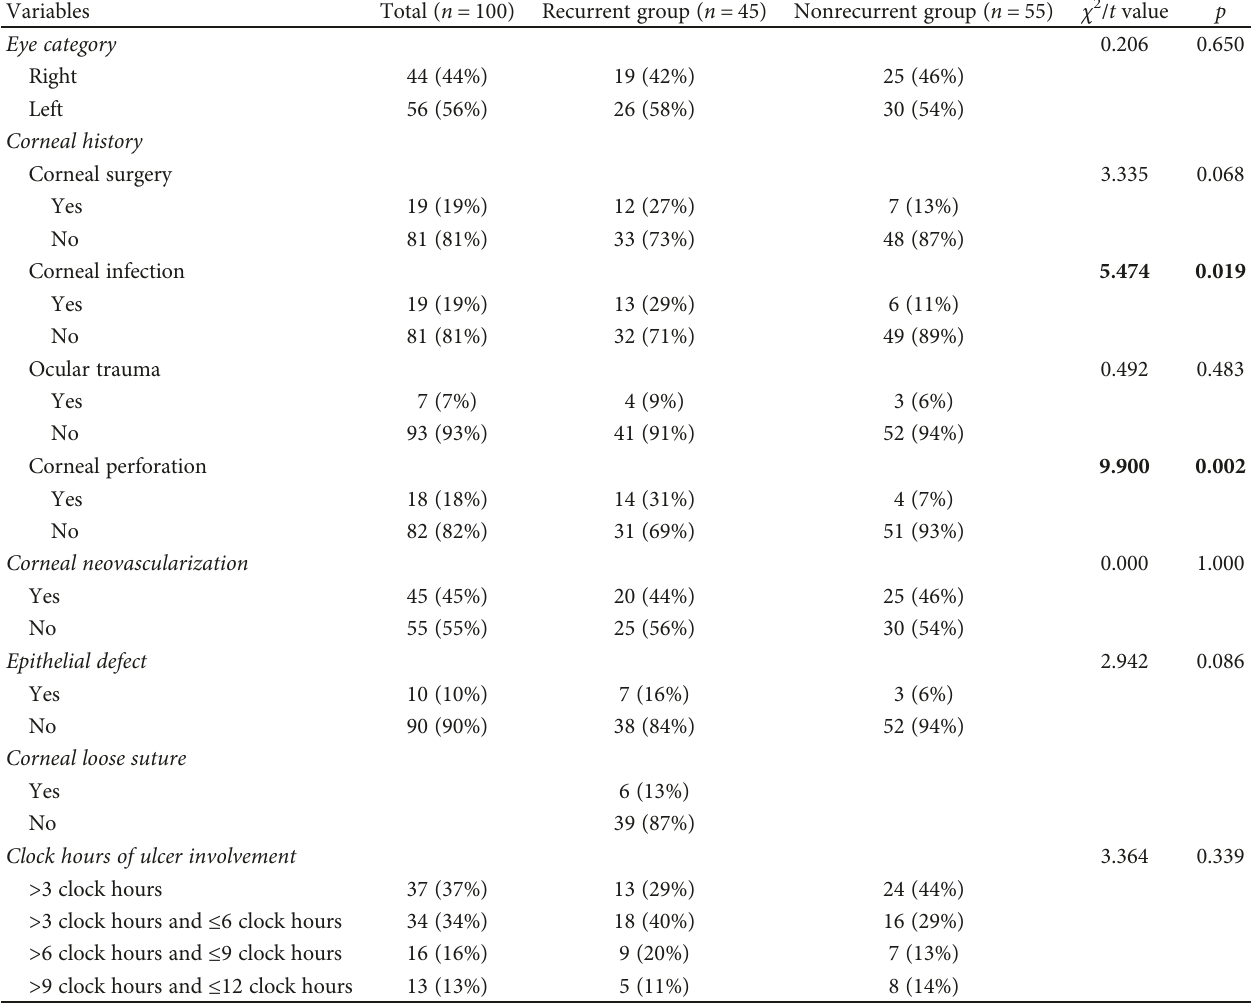
Table 2: Clinical characteristics of a ff ected eyes.